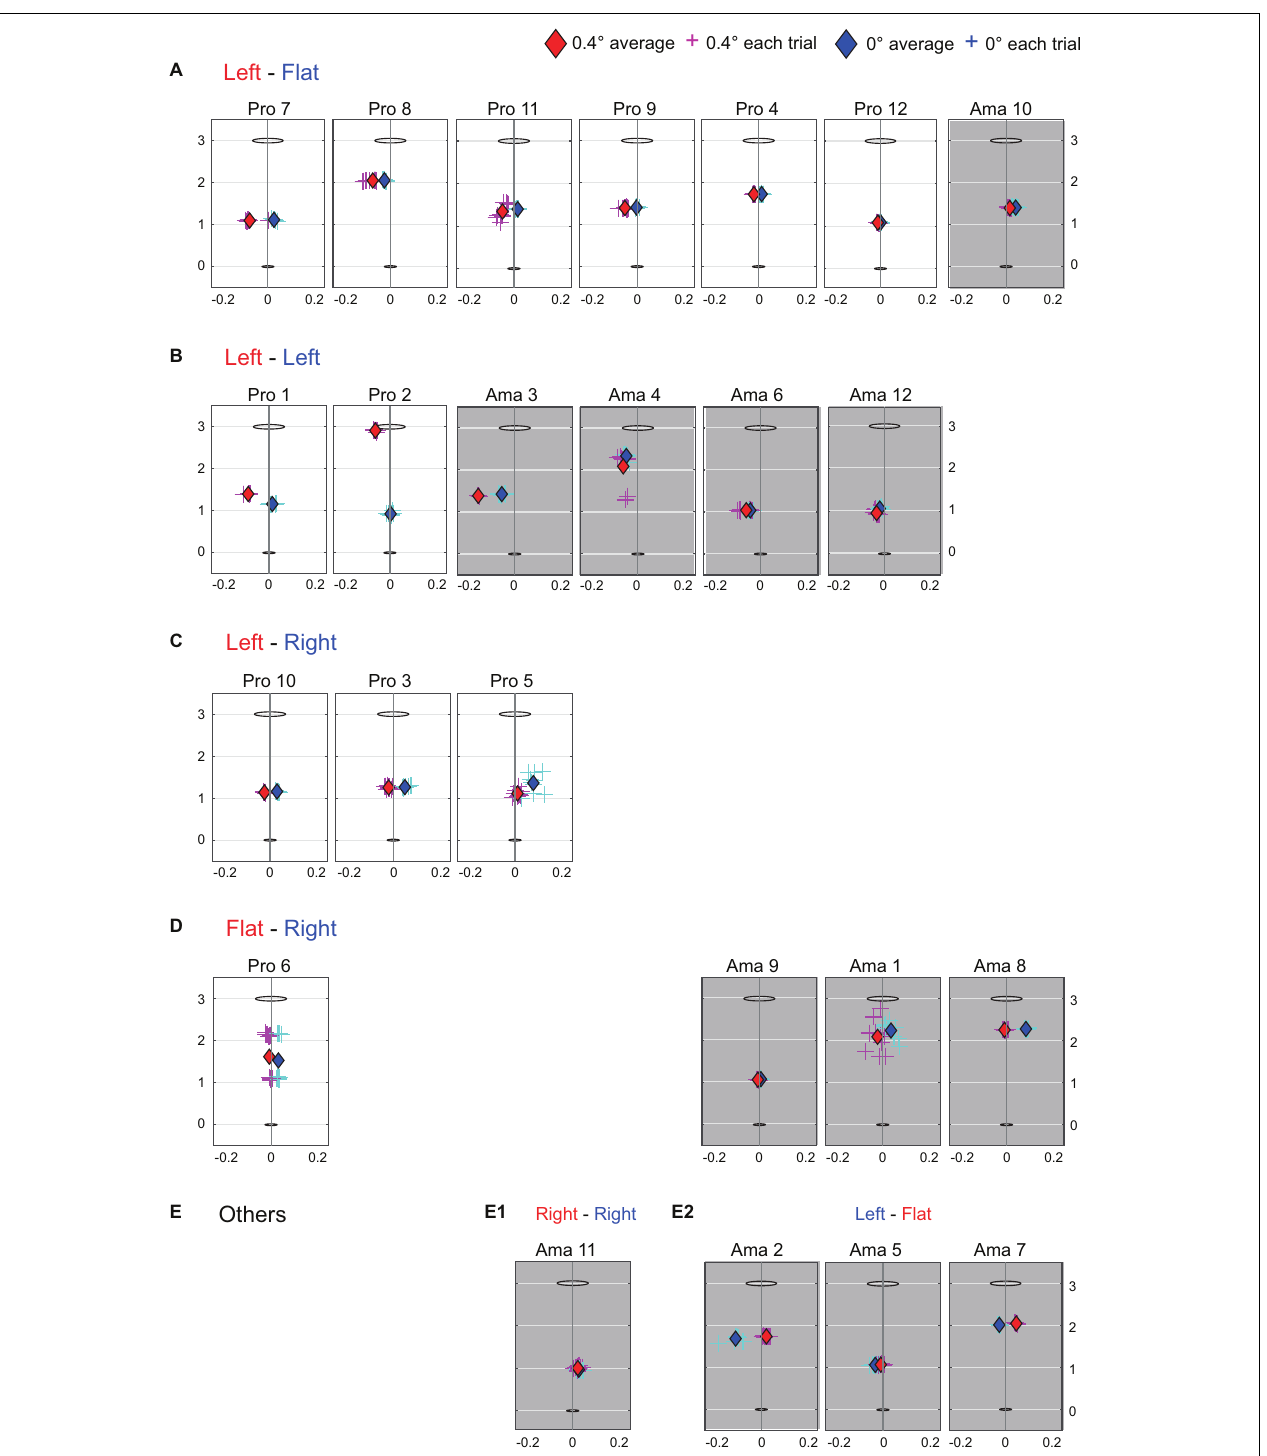
FIGURE 3 | Participants’ slope perception and average aim point in the 0- and 0.4-degree conditions. The slope perception response was divided into five patterns from (A–E) . The red letters indicate answers in the 0.4-degree condition, while the blue letters indicate answers in the 0-degree condition. For example, in (A) , the correct answer pattern is shown in which the left is high in the 0.4-degree condition and flat in the 0-degree condition. In (E) , Ama 11 stated that the right side was high in both conditions, while Ama 2, 5, and 7 said that the left side was high in the 0-degree condition and flat in the 0.4-degree condition. Besides these slope perception responses, the participants’ aim points are shown. Both the vertical and horizontal axes for each participant show the distance (m). The coordinate (0, 0) ellipse is the ball, and the coordinate (0, 3) ellipse is the hole.